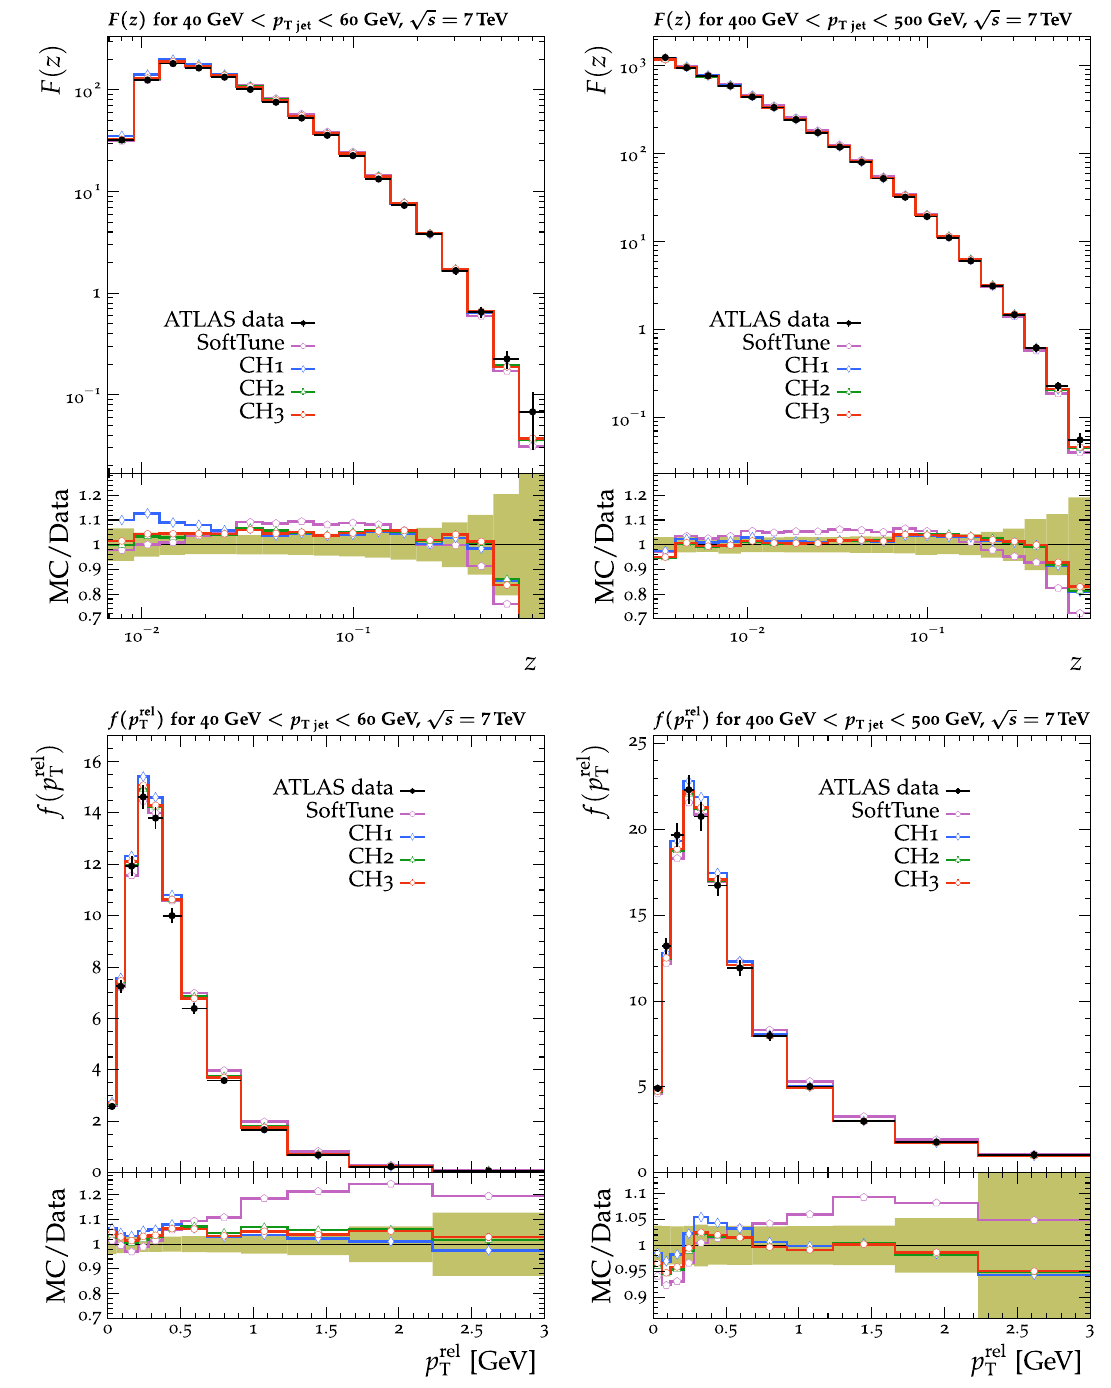
√ s = 7TeV on the F ( z ) and f ( p rel Fig. 26 The ATLAS data at ) band in the ratio plot represents the total experimental uncertainty in T distributions [17]. ATLAS inclusive jet data are compared with the pre- the data. The vertical bars on the points for the different predictions dictions from herwig 7, with the SoftTune and CH tunes. The coloured represent the statistical